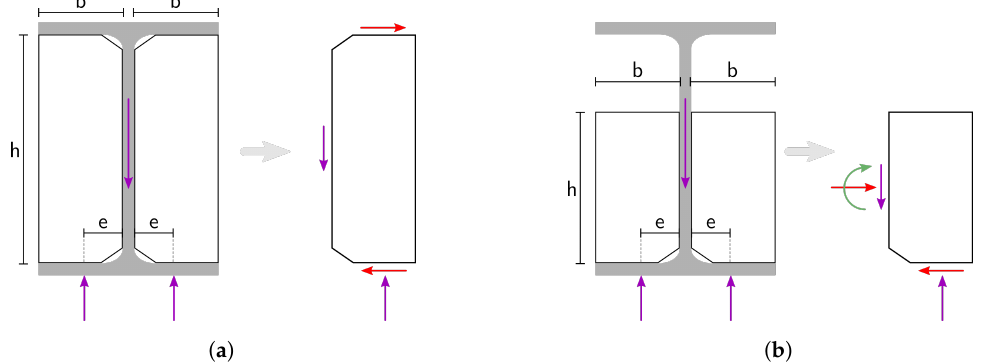
Figure 7. Forces on stiffeners for standard calculation: ( a ) full stiffener based on [24]; ( b ) partial stiffener based on [24].